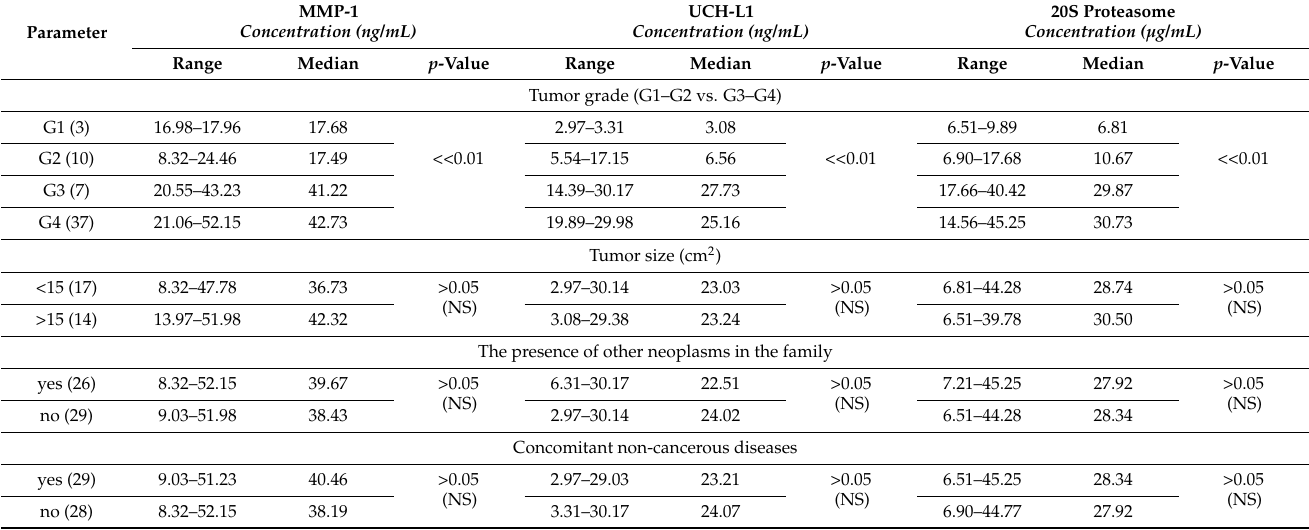
Table A3. Changes in MMP-1, UCH-L1, and 20S proteasome concentrations in comparison with the available clinical data of the samples from the